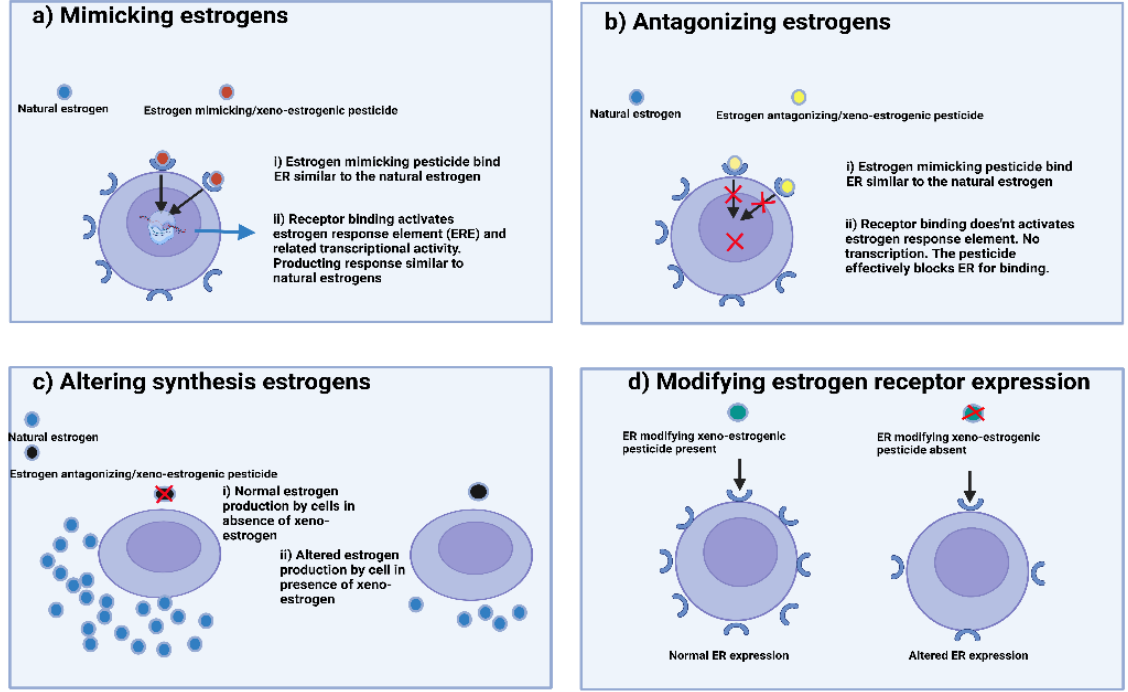
Figure 1. Different mechanisms of endocrine disruption by xeno-estrogenic pesticides: ( a ) mimicking estrogens, ( b ) antagonizing estrogens, ( c ) altering estrogen synthesis, and ( d ) modifying estrogen receptor expression.